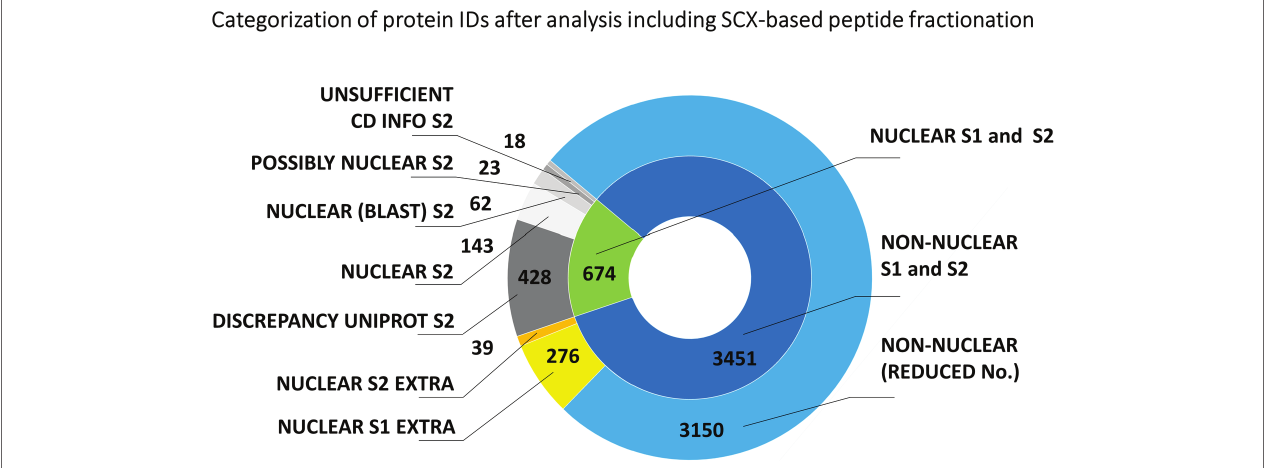
FIGURE 2 | Evaluation of the origin of proteins from mitotic chromosomes identified by nLC-ESI-Q-TOF MS/MS with SCX fractionation of tryptic peptides. The nested pie chart shows information on the possible nuclear or non-nuclear localization of all identified proteins and their distribution into categories reflecting results of a two-round search approach (S1 and S2). The principle of S1 and S2 sorting is provided in Materials and Methods. See the legend to Figure 1 for elucidation of the attributed